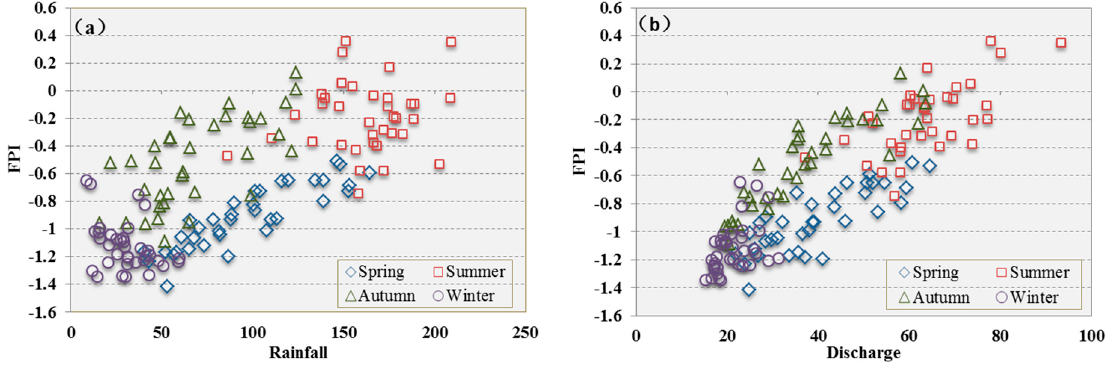
Figure 10. Scatterplots between ( a ) monthly rainfall from TRMM 3B43 and FPI and ( b ) discharge from Datong station and FPI from 2003-2014 in the Yangtze River Basin. Table 1. Flood events identified by flood potential index and their associated hydro-meteorological values in the Yangtze River